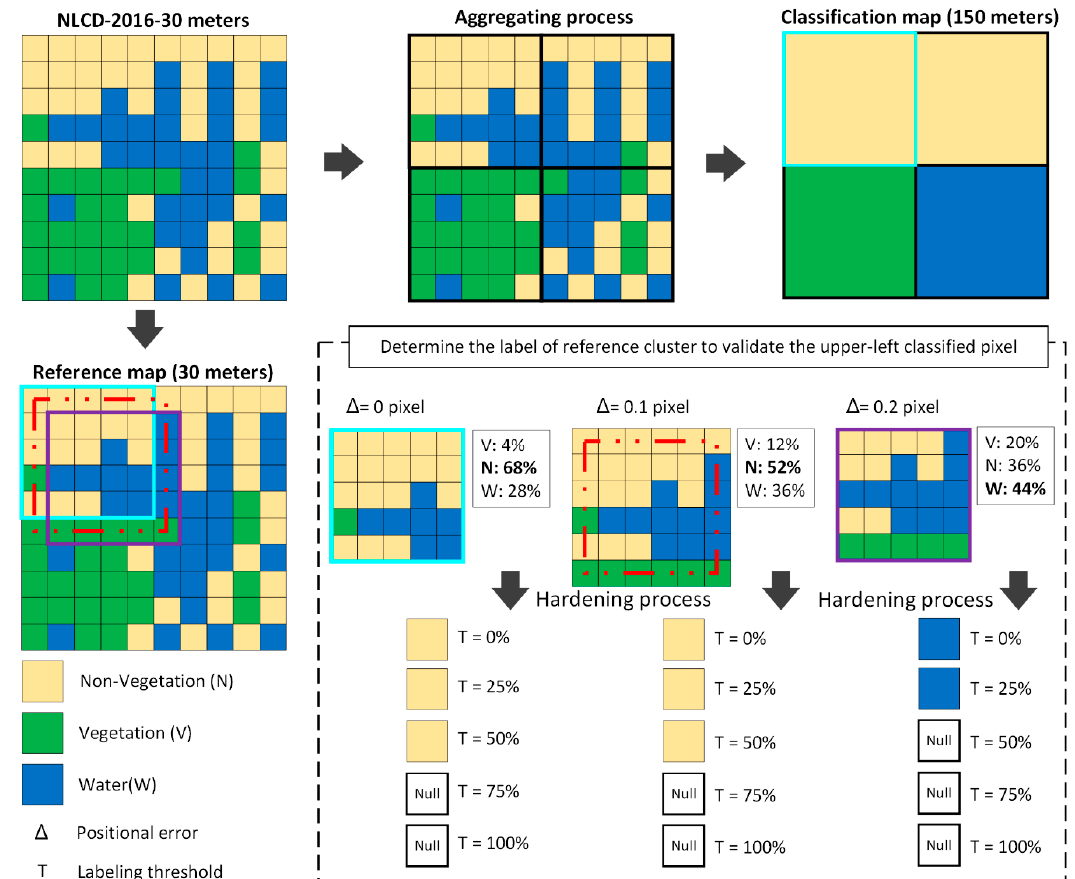
Figure 2. An example of the classification and the reference data process. In this case, a classification map at the spatial resolution of 150 m was created by aggregation using the majority rule. The